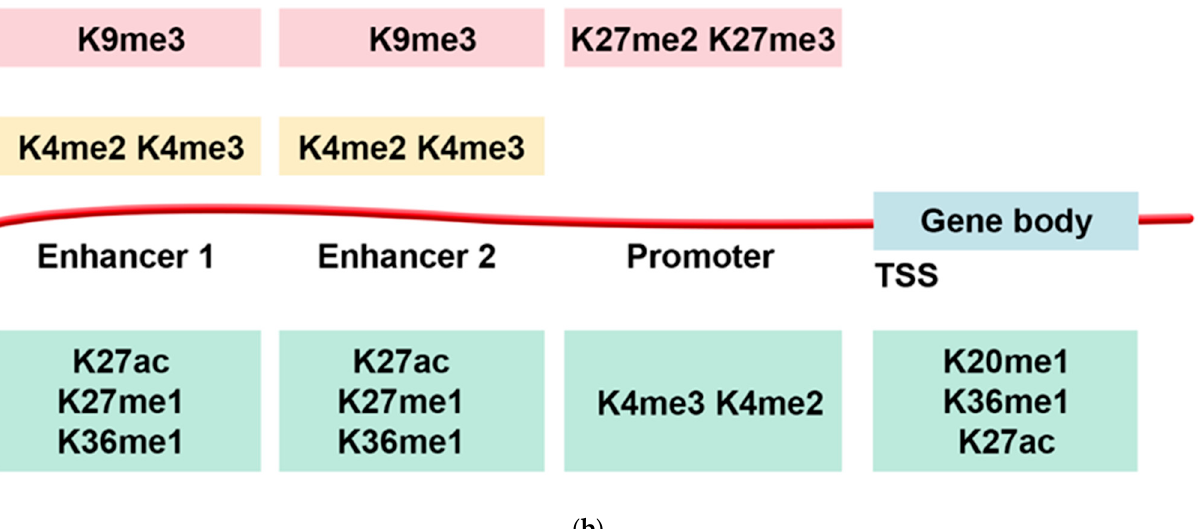
Figure 3. Epigenetic regulation of gene expression. ( a ). Histone modifications and gene expression. Histone lysine methylations and acetylations can lead to repressed, poised or activated gene expressions. A combination of histone marks that act both to repress and activate a gene leads to a poised regulation of expression of the gene. ( b ) . Sites for histone marks and gene regulation. Methylated histone 3 lysines differ in action sites on enhancers, promoters, and gene bodies of genes. Red indicates down-regulated gene expression and green indicates upregulated expression of the gene.